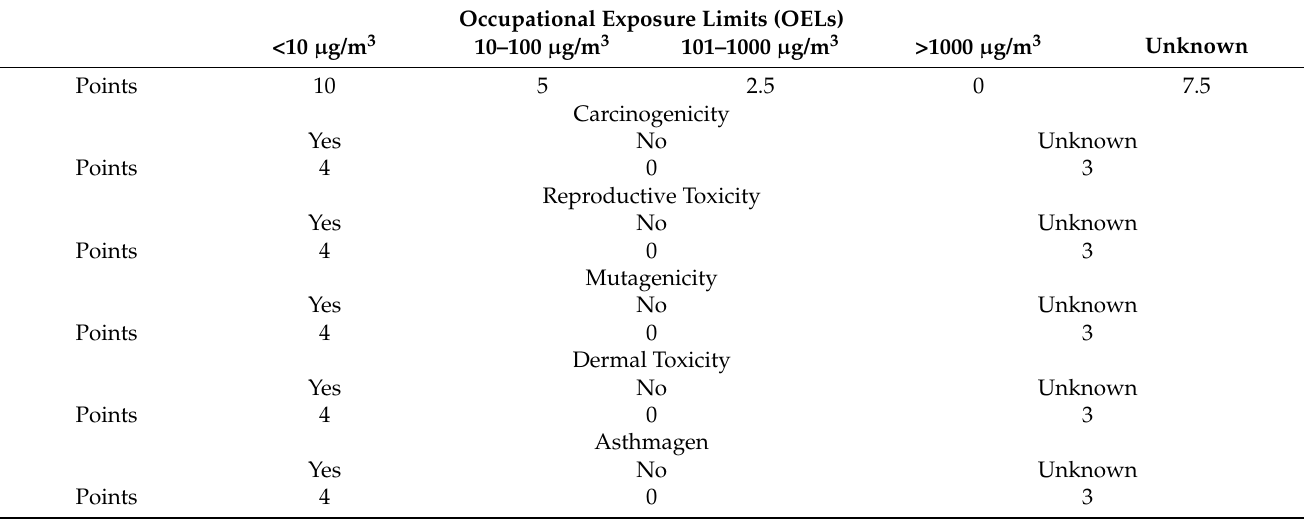
Table 2. Severity scores for parental materials.